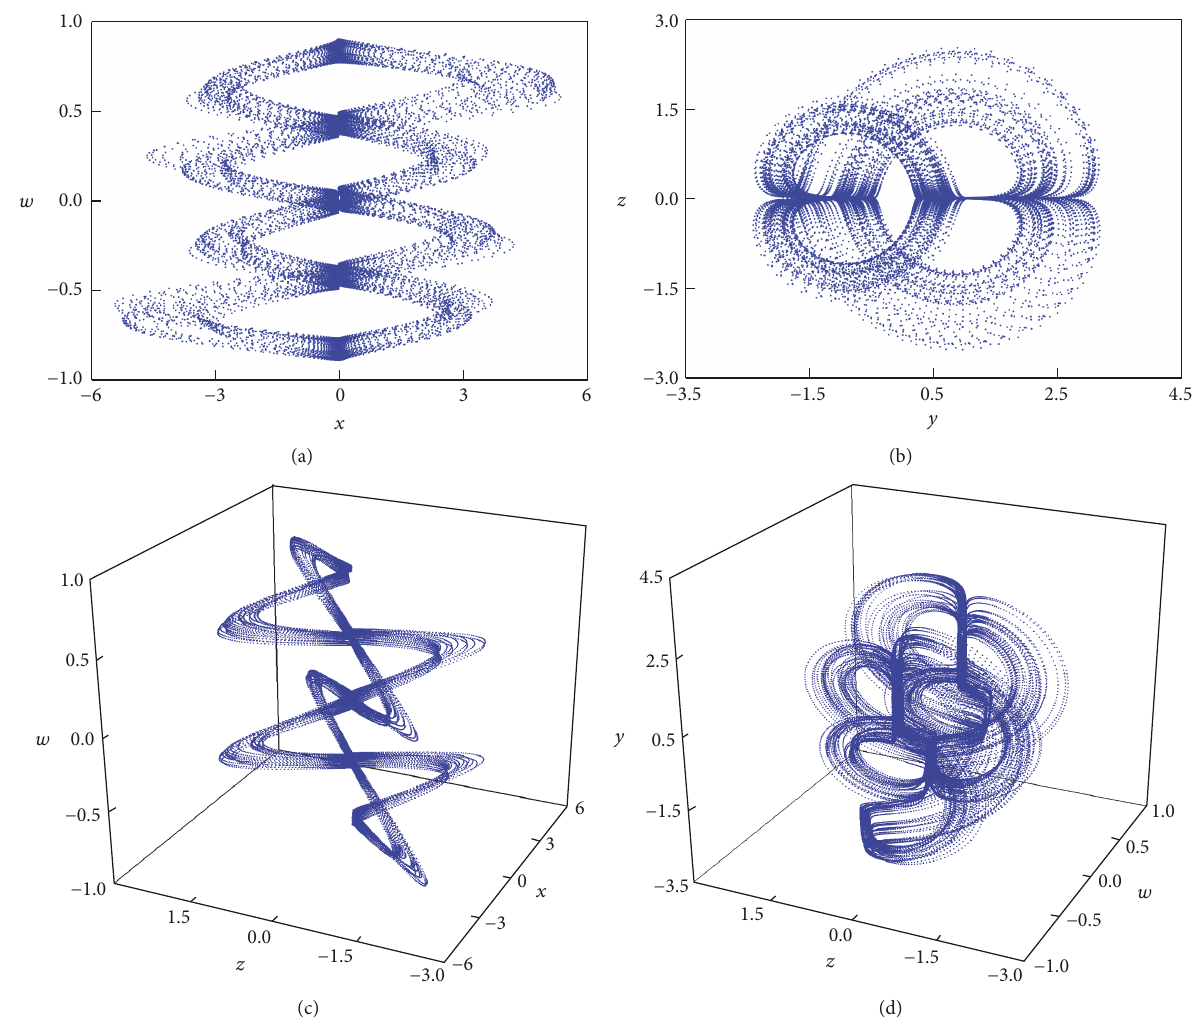
Figure 1: Phase diagrams: (a) x - w , (b) y - z , (c) x - z-w , and (d) w - z-y